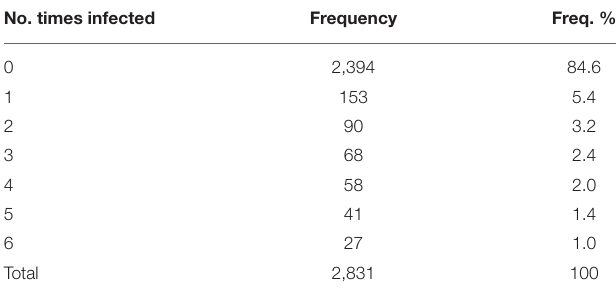
TABLE 2 | The frequency distribution of the number of times herds resulted positive for Streptococcus agalactiae during the period 2019–2021 (six semesters) in the Emilia-Romagna